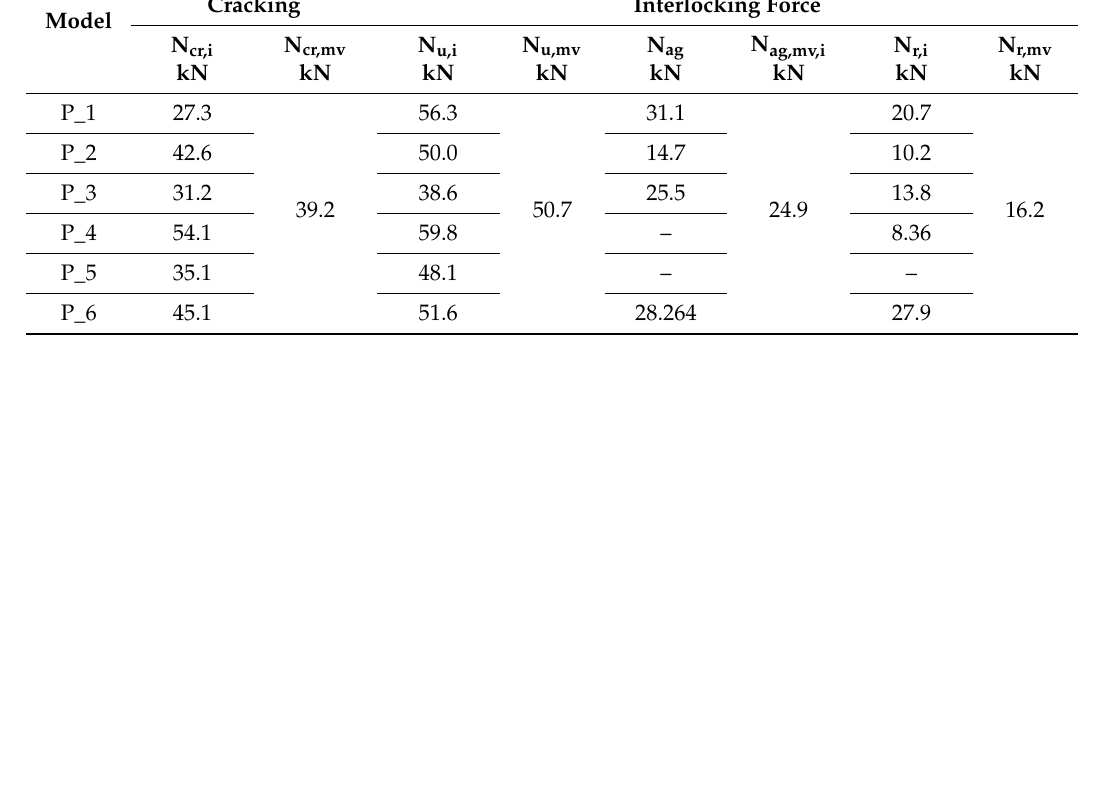
Figure 9. Relationship between the total force and mean displacement of joints.